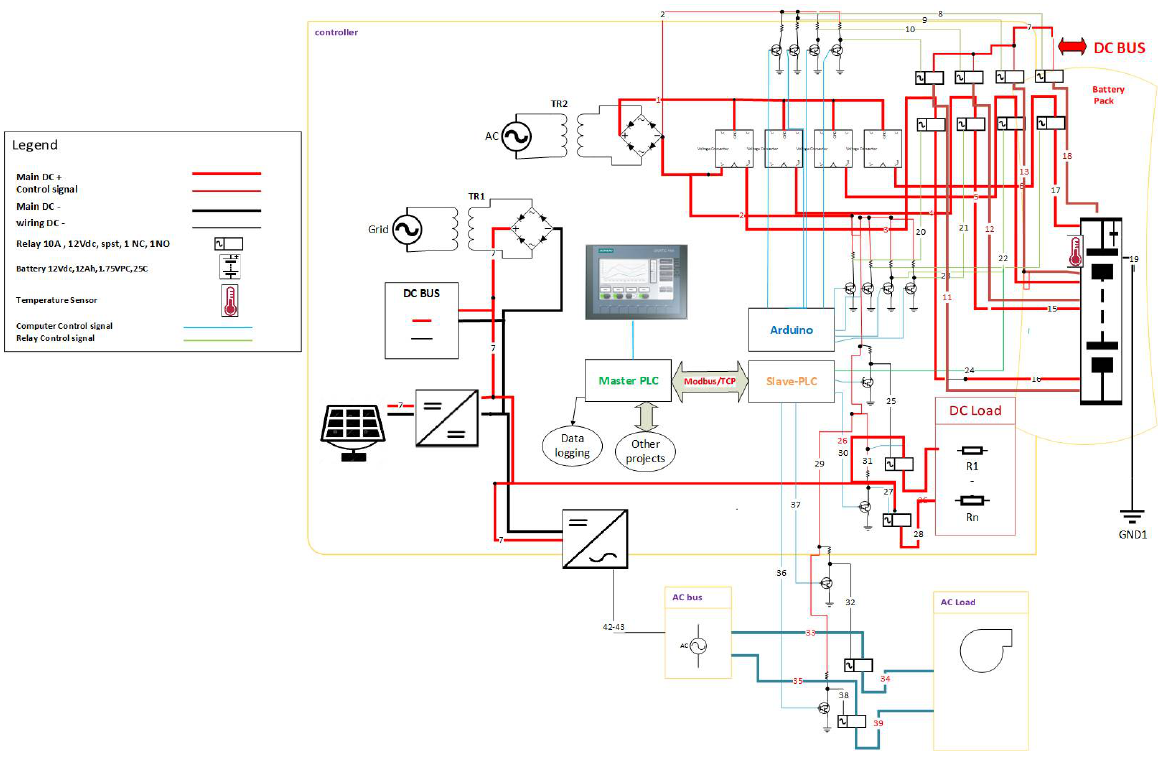
Figure 2. Circuit design.